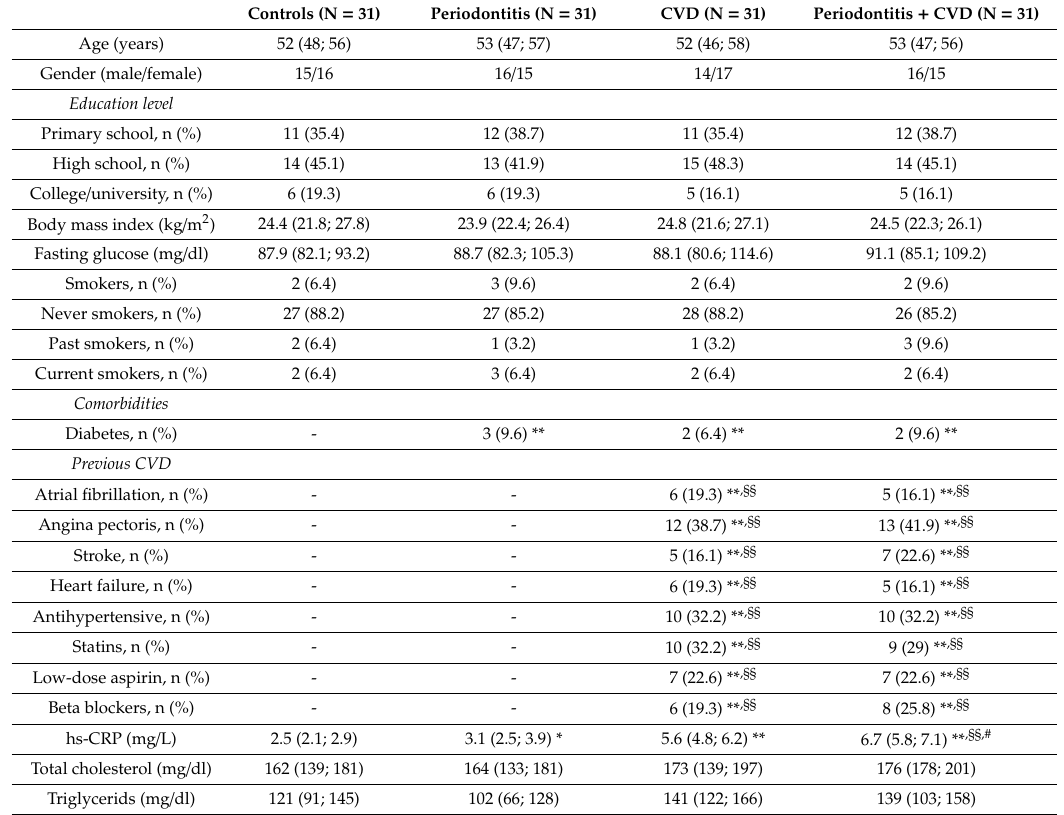
Table 1. Sample characteristics of enrolled patients. Data are represented as median (25th; 75th percentiles) or number with percentage. * p < 0.001 and ** p < 0.001 significant di ff erences vs. healthy subjects computed by the Mann Whitney test. §§ p < 0.001 significant di ff erences vs. periodontitis patients calculated by the Mann Whitney test. # p < 0.008 significant di ff erences vs. coronary heart disease (CHD) patients calculated by the Mann Whitney